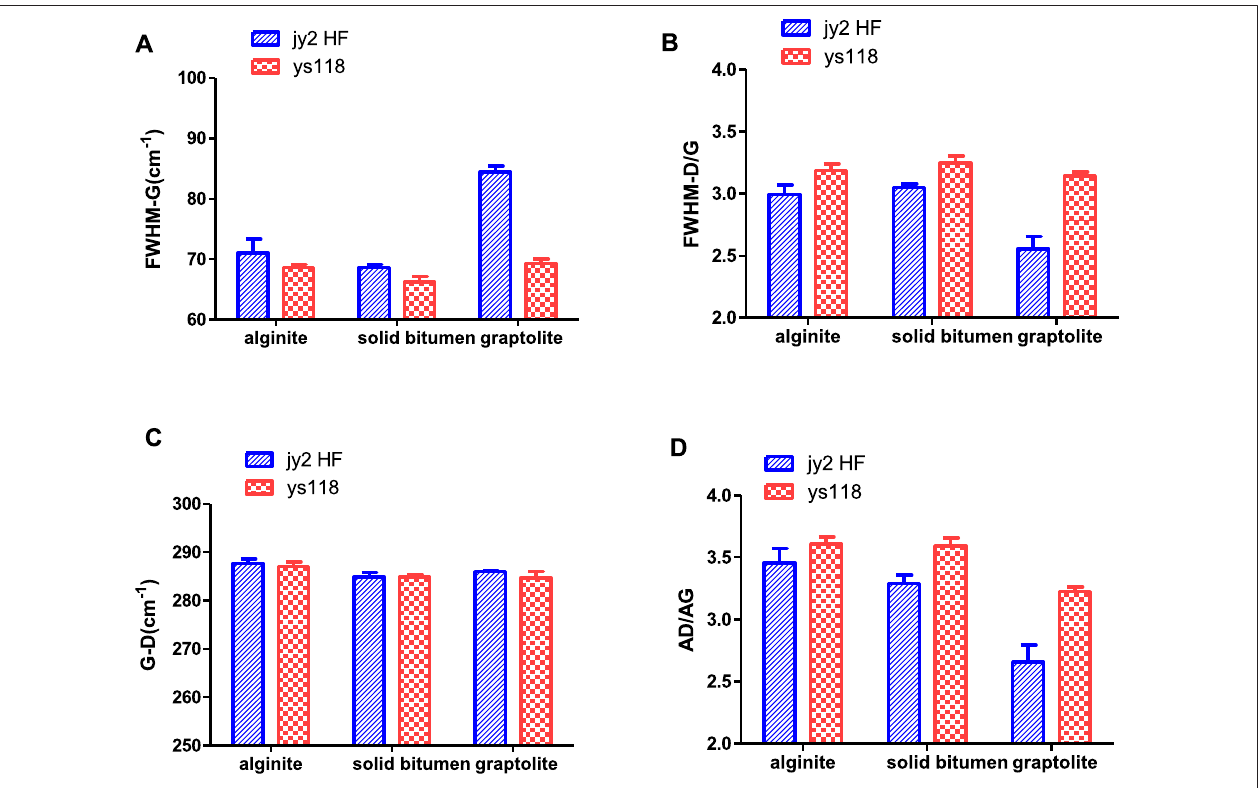
FIGURE 9 | Raman structural parameters of three macerals in different mature samples.